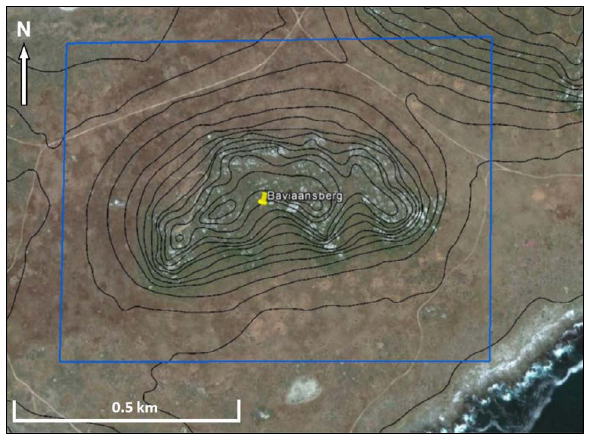
Figure 4: Google Earth image of Baviaansberg, with the topography map overlaid. The study area is indicated by a blue square.